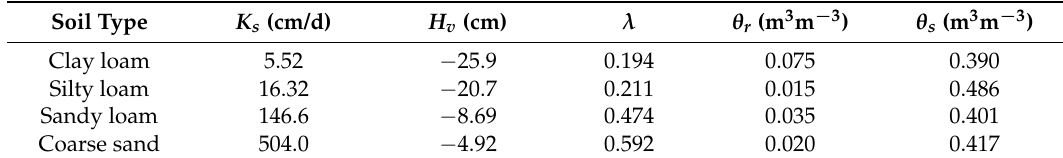
Table 4. Soil parameter values for the Brooks–Corey model in Figure 3 [39].